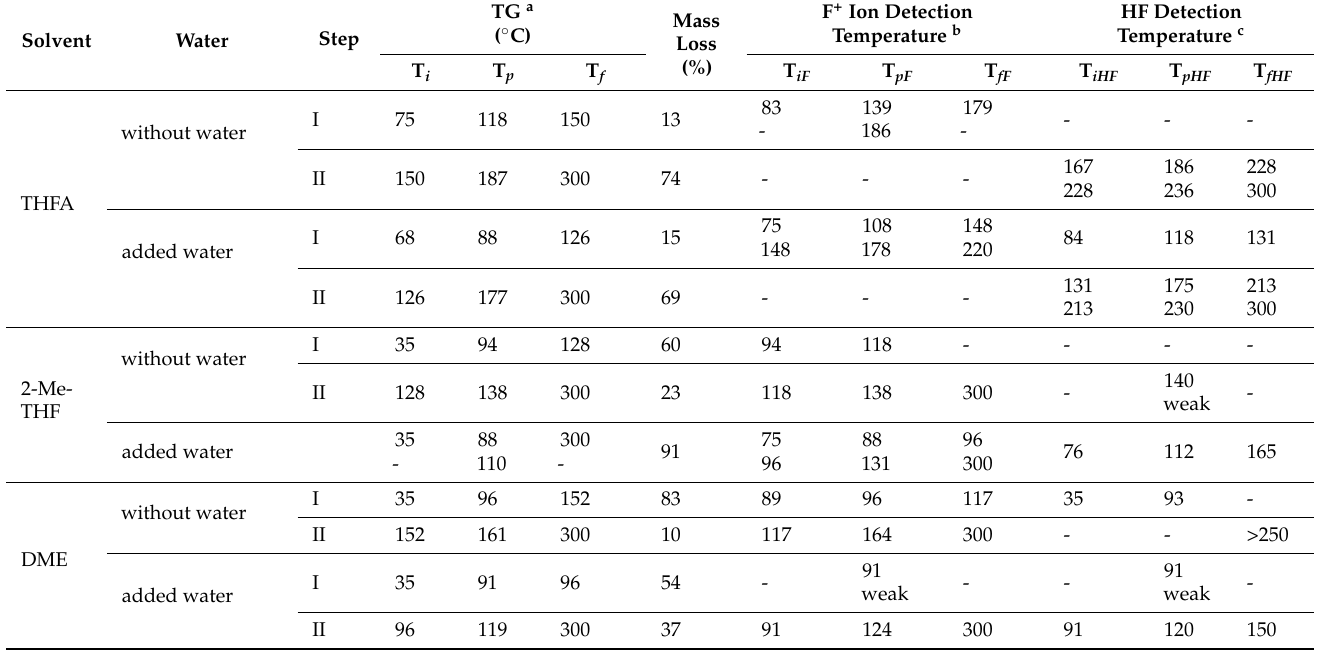
Table 2. Summary of the temperature and mass loss corresponding to TG, F + ( m / z = 19) and HF + ( m / z = 20) fragments in each